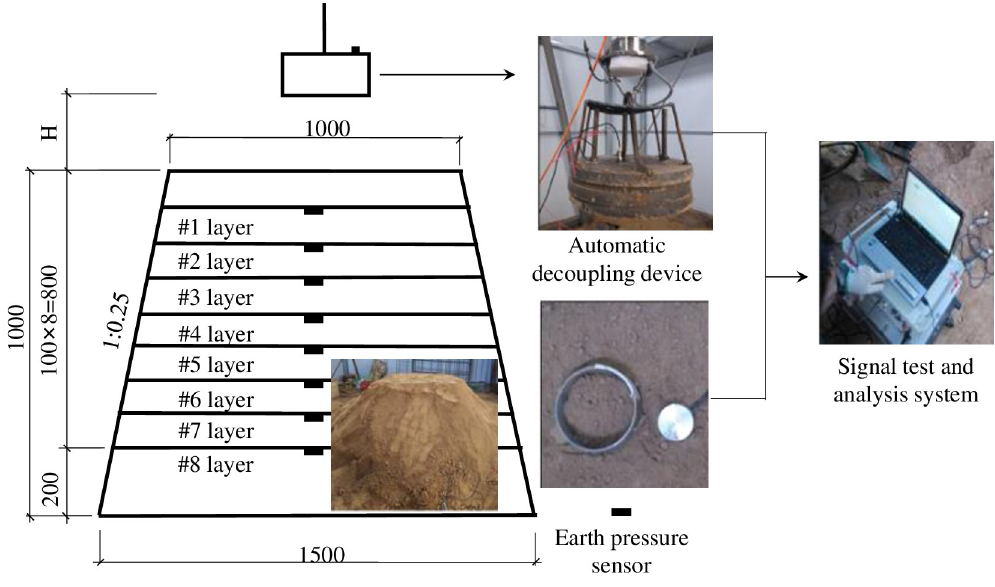
Fig 2. Schematic diagram of the model test.